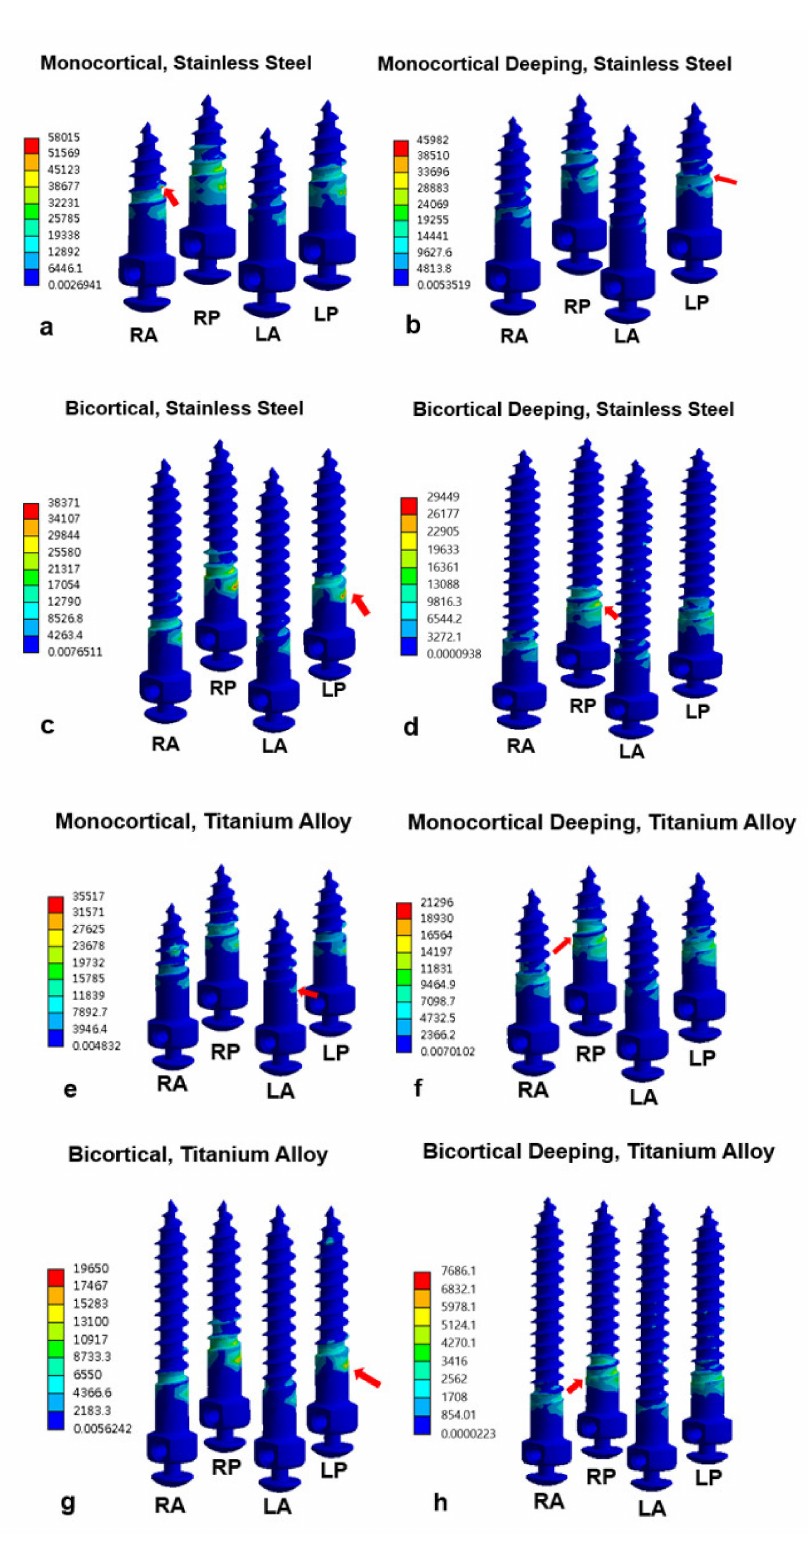
Figure 6. ( a – d ). Mean von Mises stress (MPa) of the miniscrew implants of stainless steel for the skull model with midpalatal suture for all 4 anchorage models. RA, right anterior; RP, right posterior; LA, left anterior; LP, left posterior. Red arrow represents the location of the peak stress in the FE model. ( e – h ) Mean von Mises stress (MPa) of the miniscrew implants of titanium alloy for the skull model with midpalatal suture for all 4 anchorage models. RA, right anterior; RP, right posterior; LA, left anterior; LP, left posterior. Red arrow represents the location of the peak stress in the FE